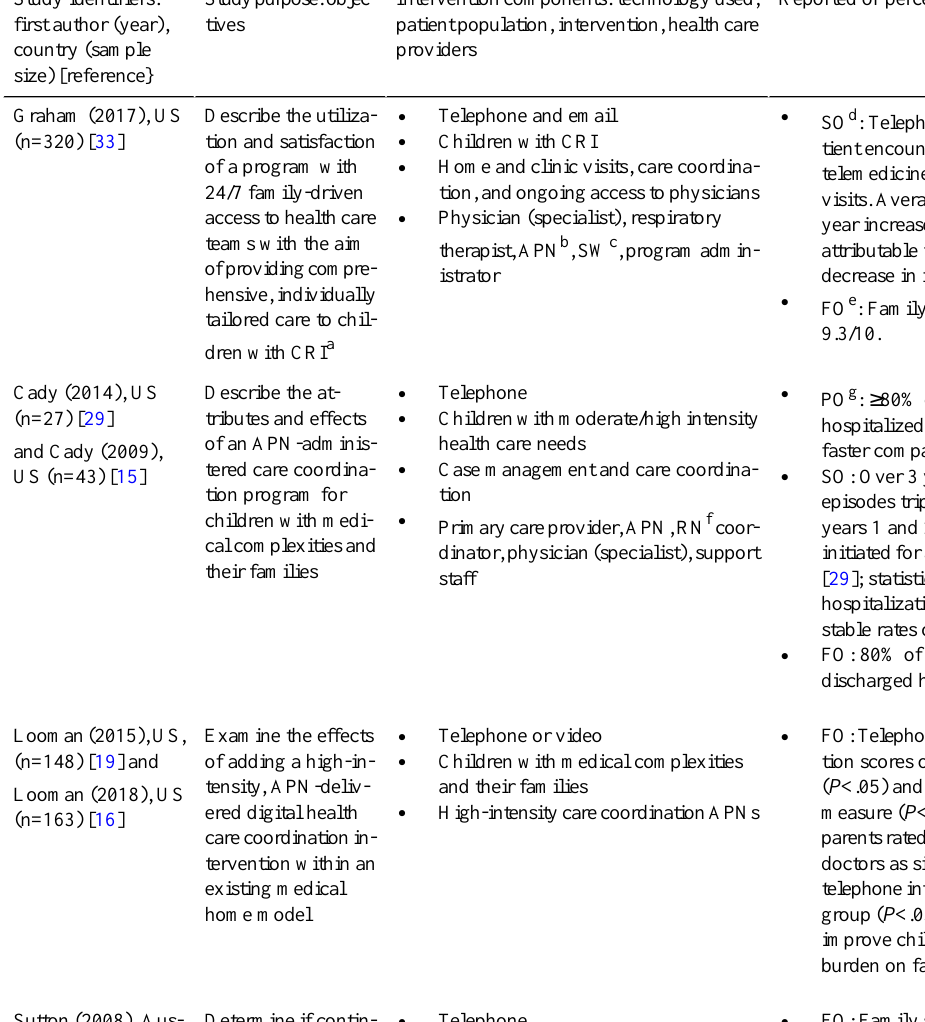
Reported or perceived outcomesIntervention components: technology used,